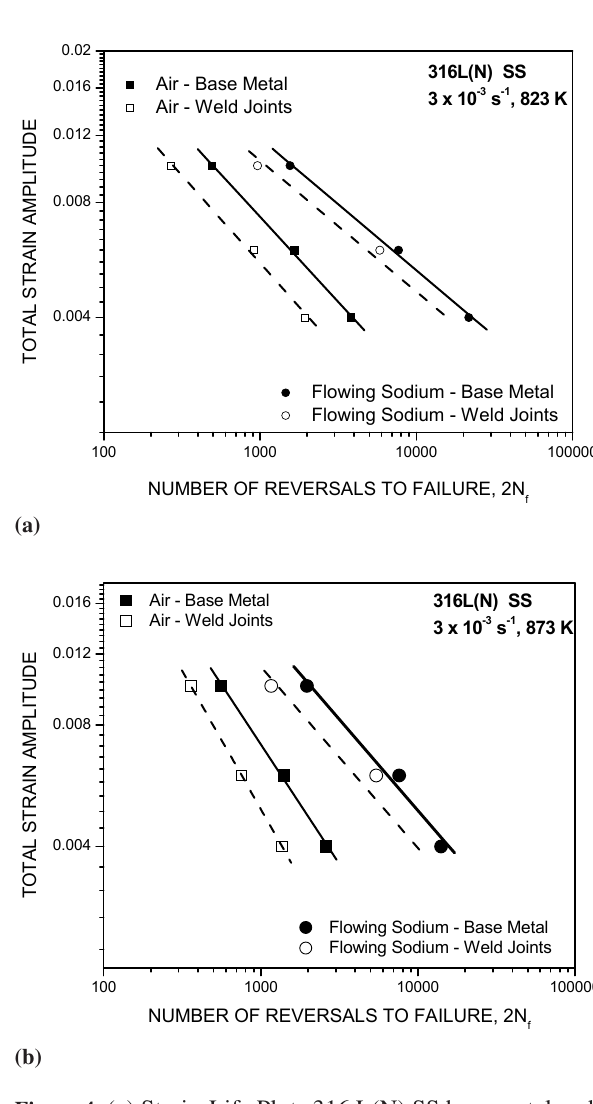
Figure 4. (a) Strain-Life Plots 316 L(N) SS base metal and weldments at 823 K; (b) Strain-Life Plots 316 L(N) SS base metal and weldments at 873